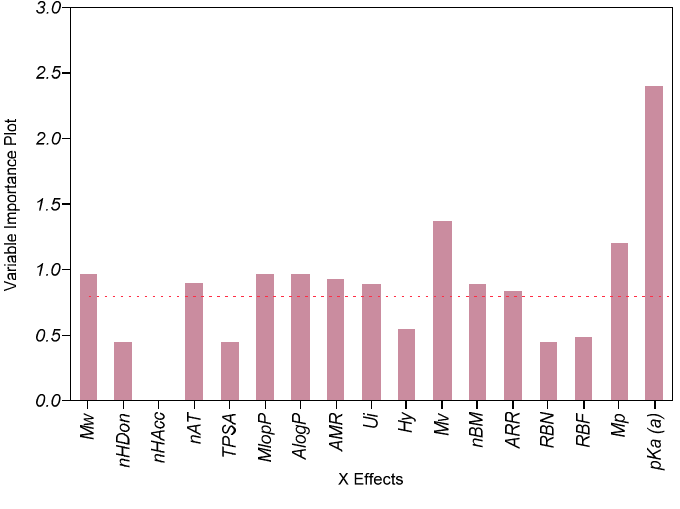
Figure 8. Evaluation of importance of calculated predictors on experimental solubility in FaSSIF by PLS analysis.